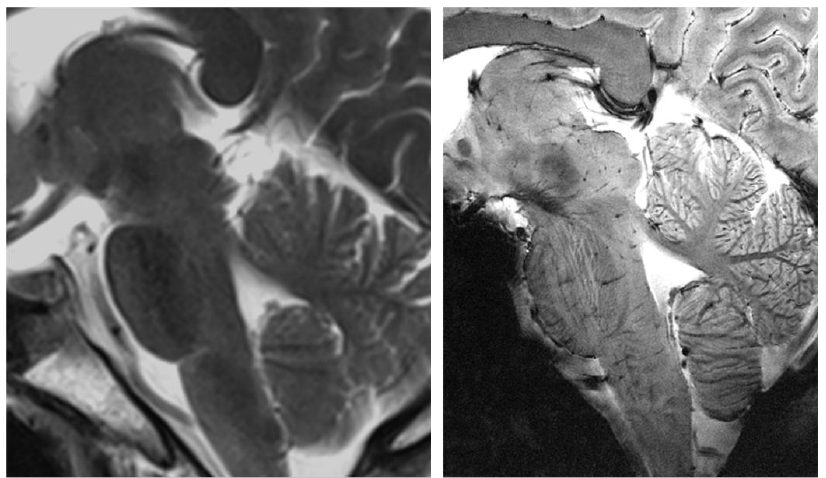
Figure 1. Comparison of 3.0T ( left ) and 7.0T ( right ) MRI in the brainstem area. As shown above, markedly different detail is visualized on the 7.0T MRI, such as the details of the thalamic and brainstem areas, including the midbrain and pons. Reprinted with permission from Cho et al., 2014, Elsevier [13].